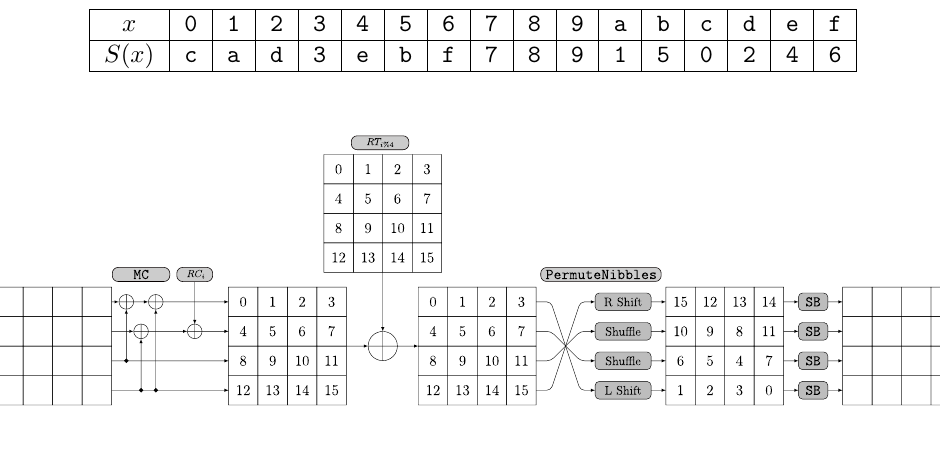
Figure 1: A round of